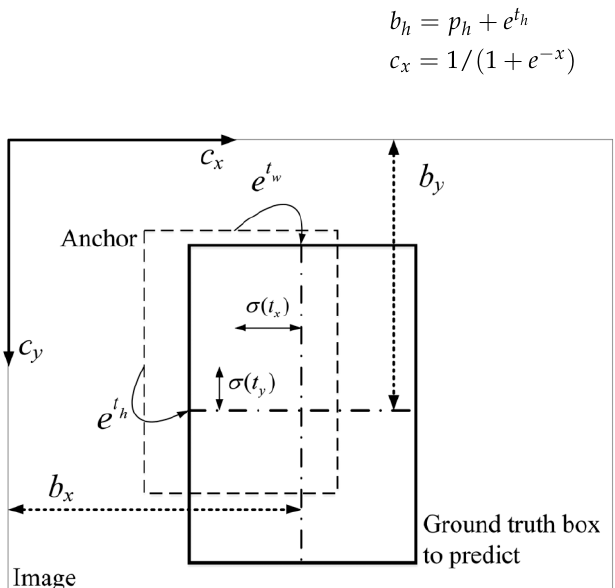
Figure 3. The decoding schematic.